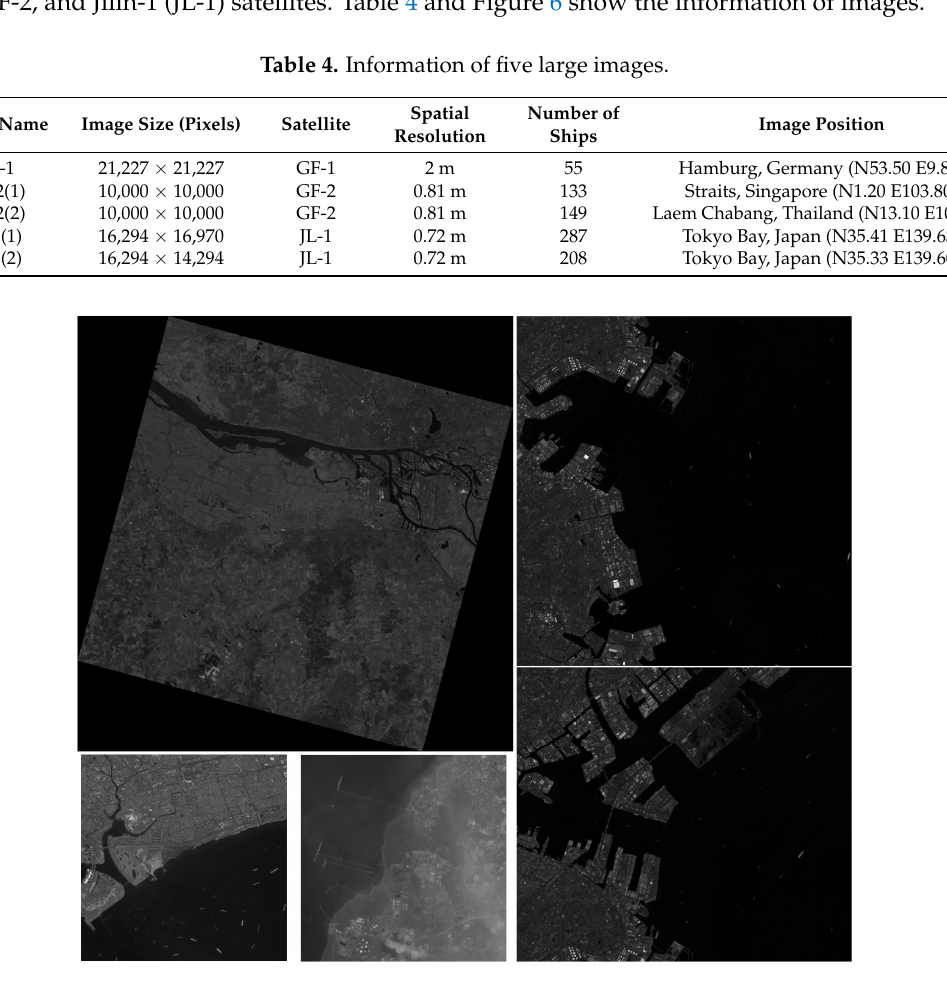
Figure 6. The five test large images. The images on the left are GF-1, GF-2(1), and GF-2(2), and the images on the right are JL-1(1) and JL-1(2).